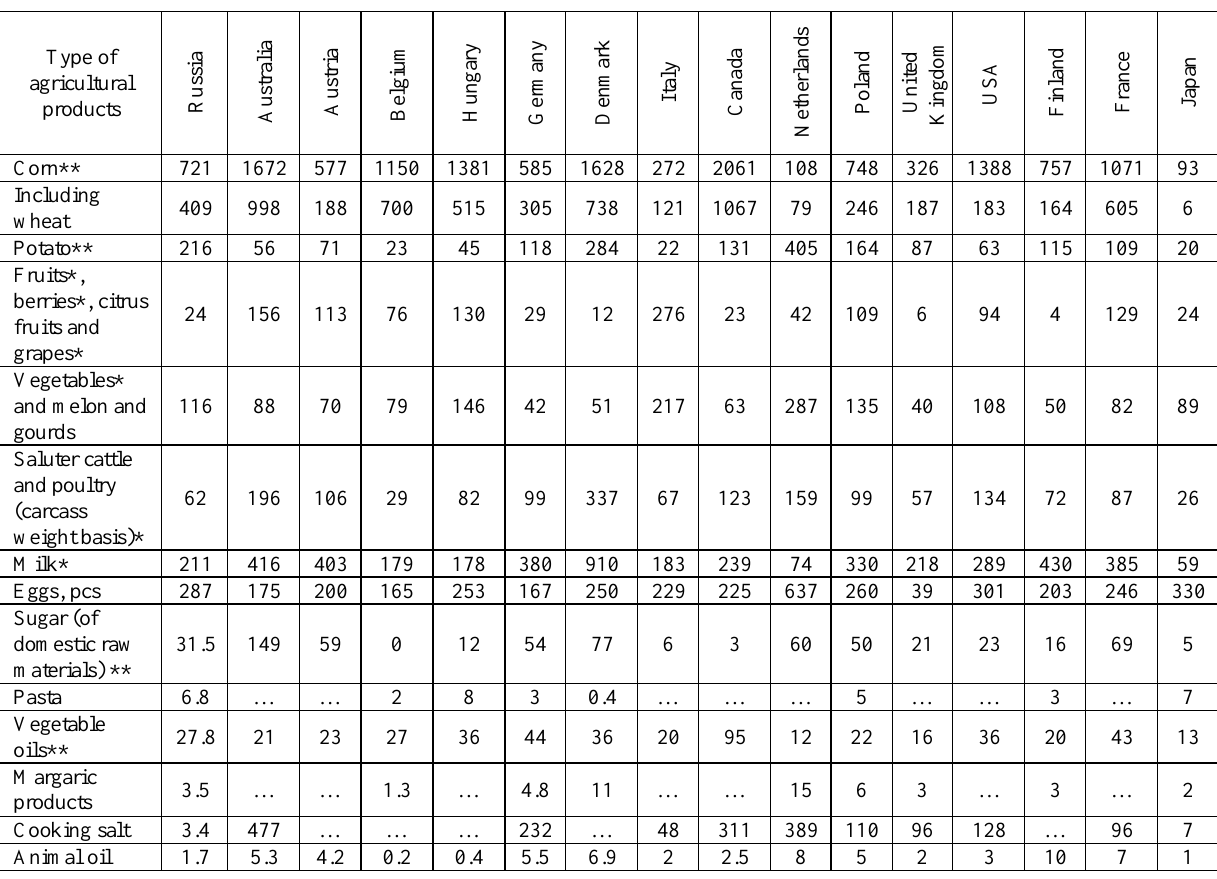
Table 1. Production of most important types of farm products and foodstuffs in 2013 in Russia and in several world countries per capita, kg